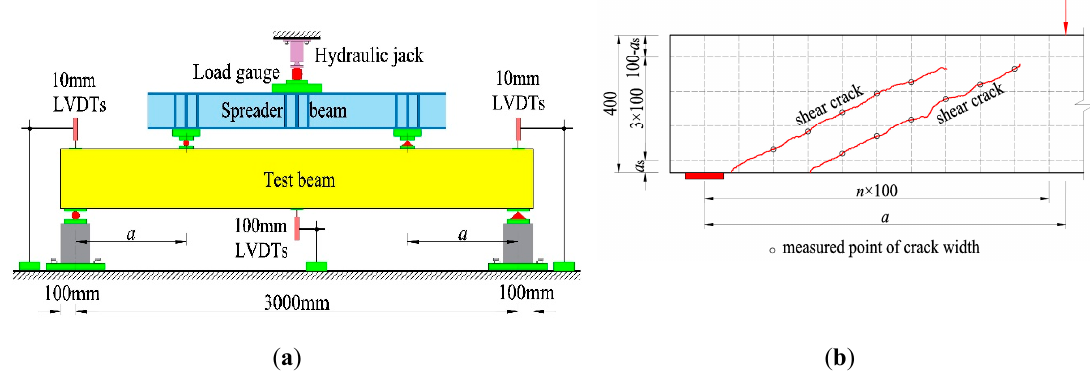
Figure 1. Test setup and measurement of shear crack width: ( a ) test setup; ( b ) measurement of shear crack width.